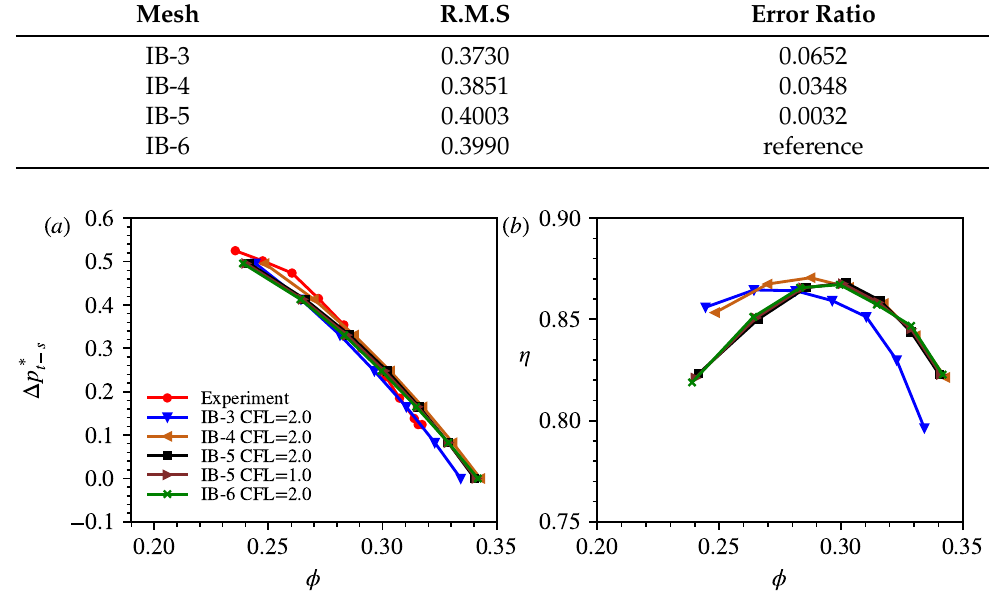
Table 4. R.M.S values of the unsteady pressure shown in Figure 7 and their error ratios to the reference data.